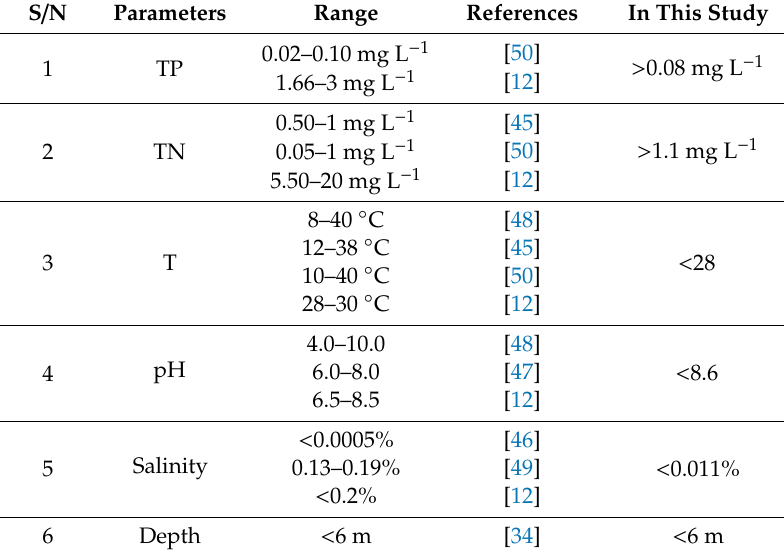
Figure 5. Suitable area of Lake Tana in terms of major factors for water hyacinth growth in August. Table 2. Threshold values of water quality parameters in comparison with previous